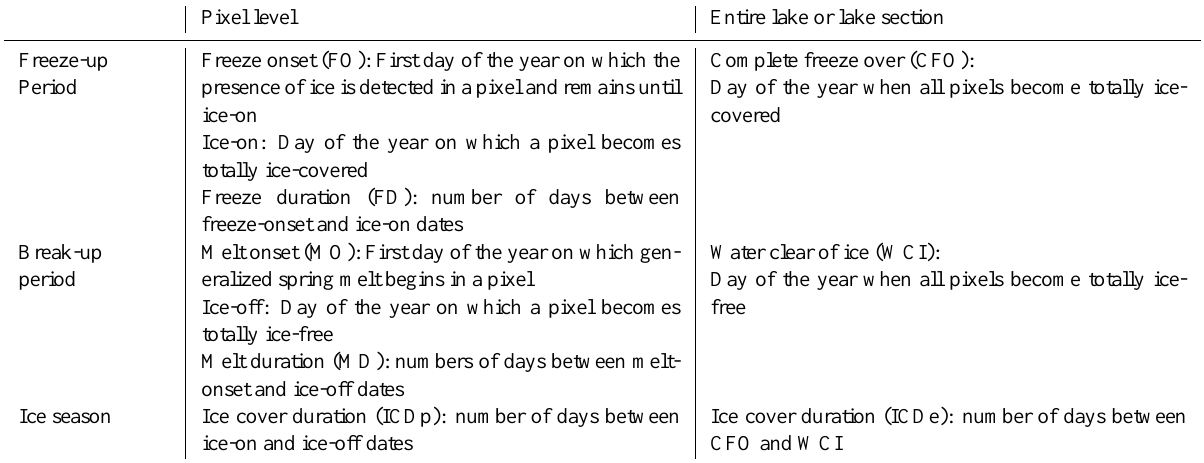
Table 1. Definition of ice phenology variables at per pixel level and for entire lake or lake section.